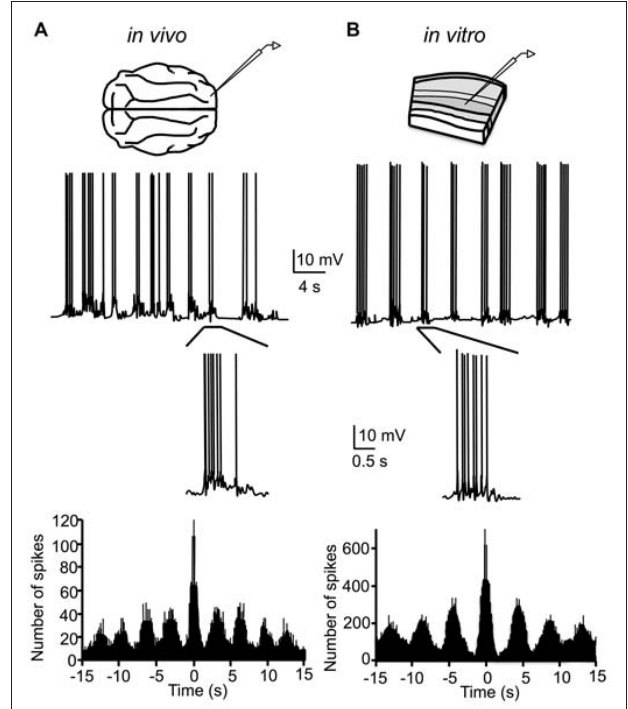
FIGURE 2 | Original demonstration of the slow oscillation in cortical slices. (A) Intracellular recording of cortical neuron in cat primary visual cortex during the slow oscillation under halothane anesthesia. Rhythmicity is quantified by the autocorrelogram of the intracellular record (bottom). (B) Intracellular recording of cortical neuron of ferret visual cortex in vitro in “modified ACSF.” The slow oscillation in vitro is also rhythmic (bottom), though with a longer oscillation period than the in vivo slow oscillation. (A,B) adapted by permission from Macmillan Publishers Ltd: Nature Neuroscience (Sanchez-Vives and McCormick, 2000), ©